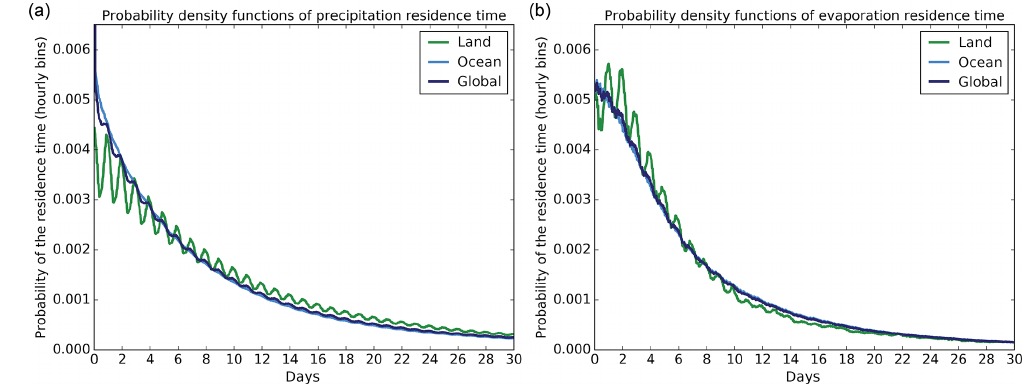
Figure 4. Probability density functions (PDFs) of atmospheric residence time as computed by 3D-T based on ERA-Interim data (2002– 2008). (a) PDFs of precipitation residence time, and (b) PDFs of evaporation residence time. About 5% of the moisture has residence times of more than 30